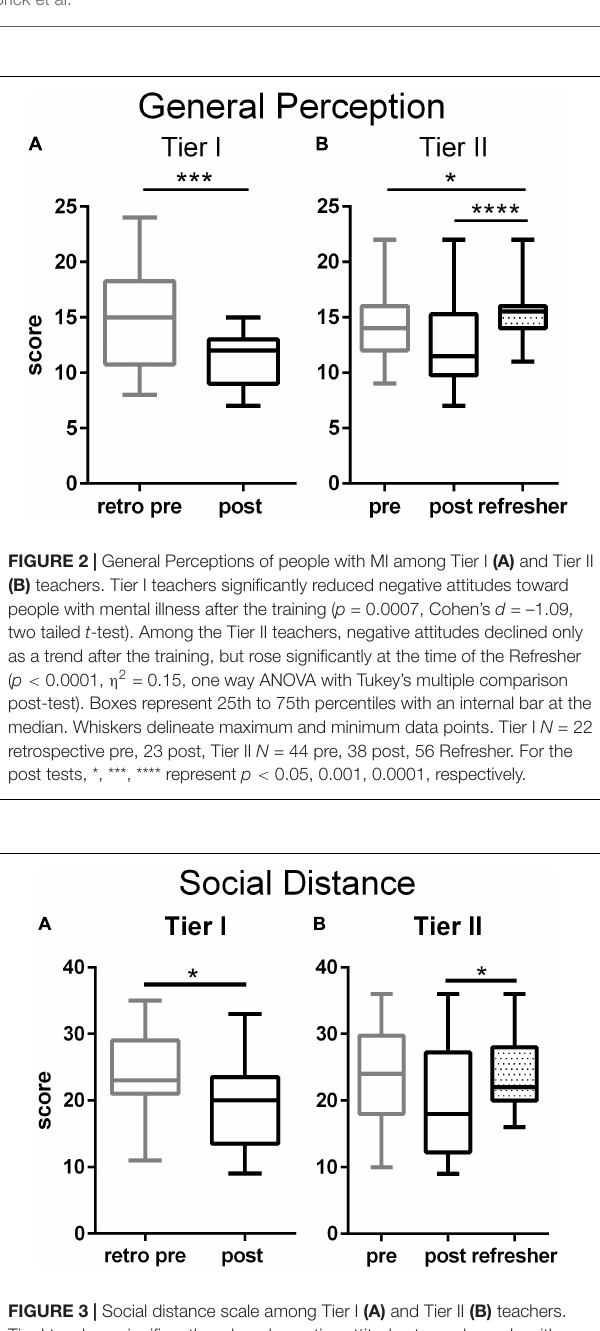
full scale or on any subscale ( Figures 4C,D ). At the